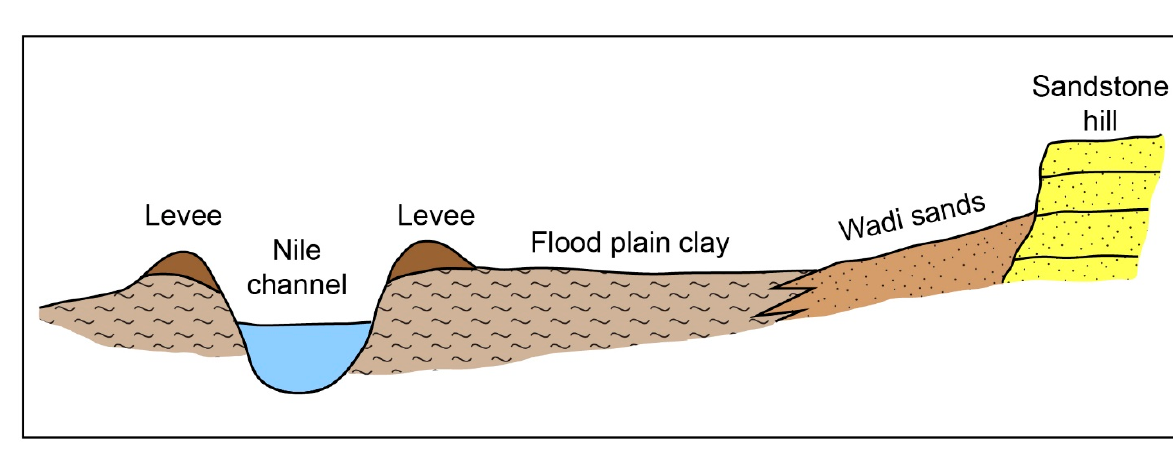
Figure 6. Hypothetical section from the main Nile channel across its flood plain to where it merges with local wadi sediments. Based on the author’s observations immediately east of the Nile in northern Sudan. Table 3. Depositional environments and associated sedimentary facies in the Nile valley. For further details, see [52–54].